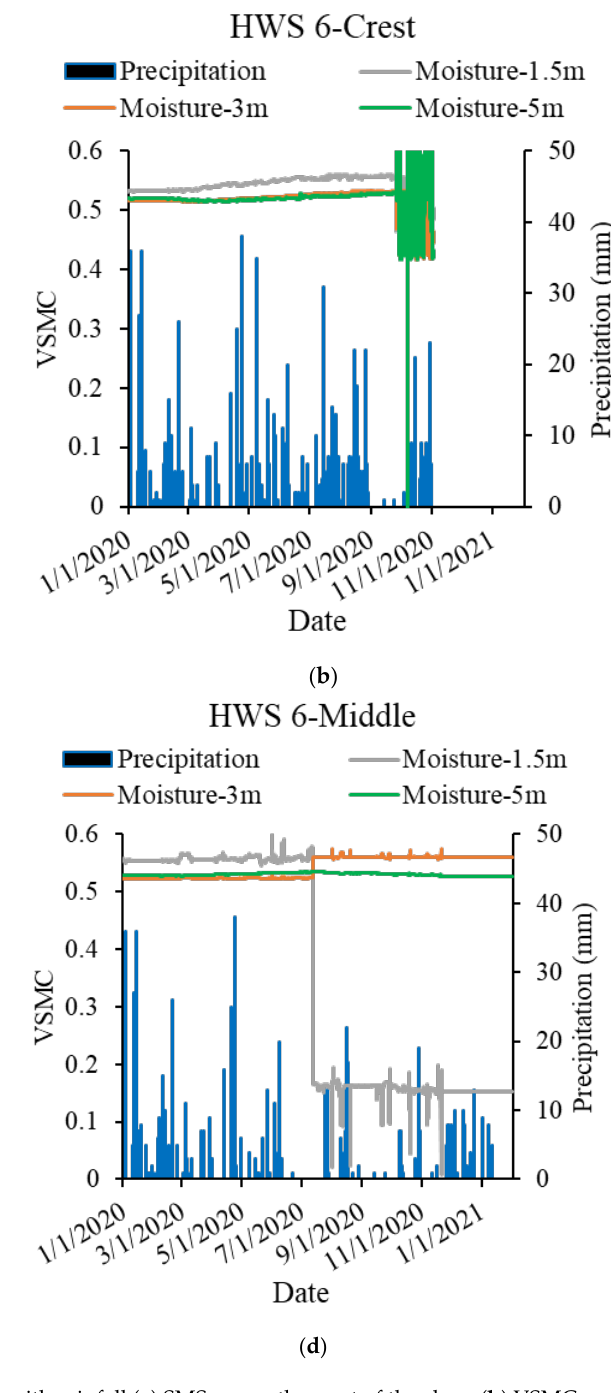
Figure 29. HWS 6 in situ variations with rainfall ( a ) SMS across the crest of the slope ( b ) VSMC across the crest of the slope ( c ) SMS across the middle of the slope ( d ) VSMC across the middle of the slope (1 m = 3.28 ft; 1 mm = 0.039 in; 1 kPa = 20.89 psf).